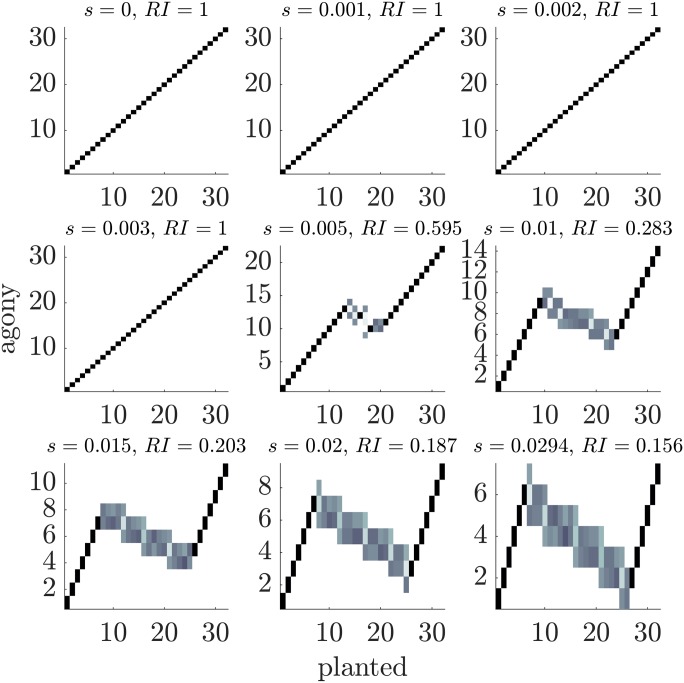
Heat maps comparing the ranking inferred using agony with the planted ranking for military-like hierarchy.In each panel a square in position (i, j) contains the number of nodes that belong to class i in the planted rank and are placed in class j by agony: the darker the color, the higher the number. The parameters are p = 0.5, q = 0, R = 32, s varies in [0, smax], with smax = 0.0294, and each plot refers to a single realisation of the ensemble.